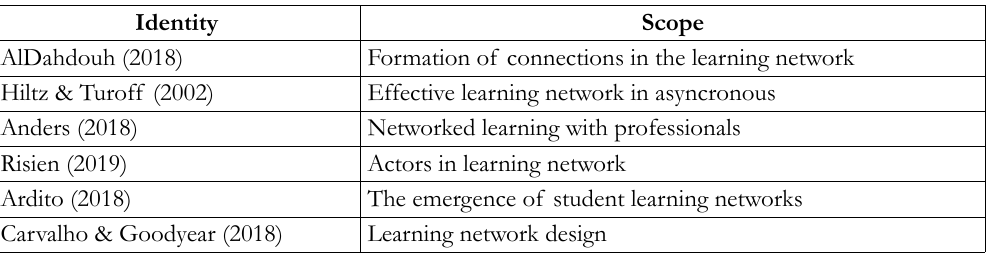
Table 3. relevant literature in designing the initial